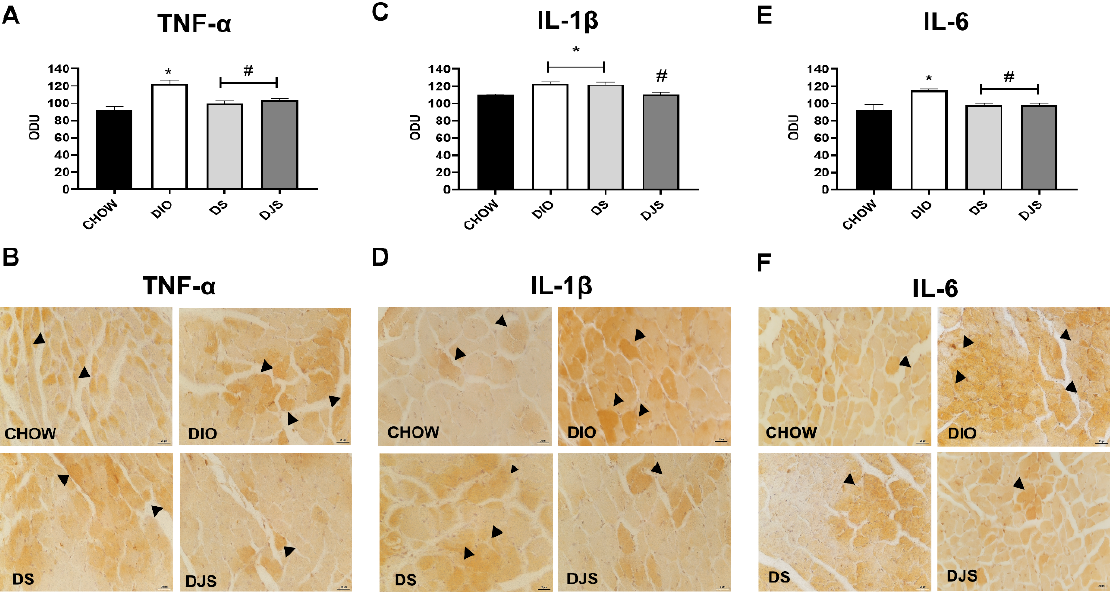
Figure 8. Immunohistochemical analysis of inflammatory cytokines. Graphs indicate the mean intensities of area immunoreaction of tumor necrosis factor- α (TNF- α ) ( A ), anti-interleukin-1 β (IL-1 β ) ( C ), and interleukin-6 (IL-6) ( E ) measured in the arbitrary optical density unit (ODU). Data are mean ± SEM. * p < 0.05 vs. CHOW rats; # p < 0.05 vs. DIO rats. Immunohistochemical representative pictures of heart sections processed for TNF- α ( B ), IL-1 β ( D ), and IL-6 ( F ). The immunoreactive cardiomyocytes are indicated with arrowheads. Magnification 40 × . Scale bar 25 µ m. CHOW rats ( n = 8), fed with standard diet; DIO rats ( n = 9), fed with high-fat diet; DS ( n = 12), DIO rats supplemented with tart cherry seeds; DJS ( n = 9), DS rats supplemented with tart cherry juice.